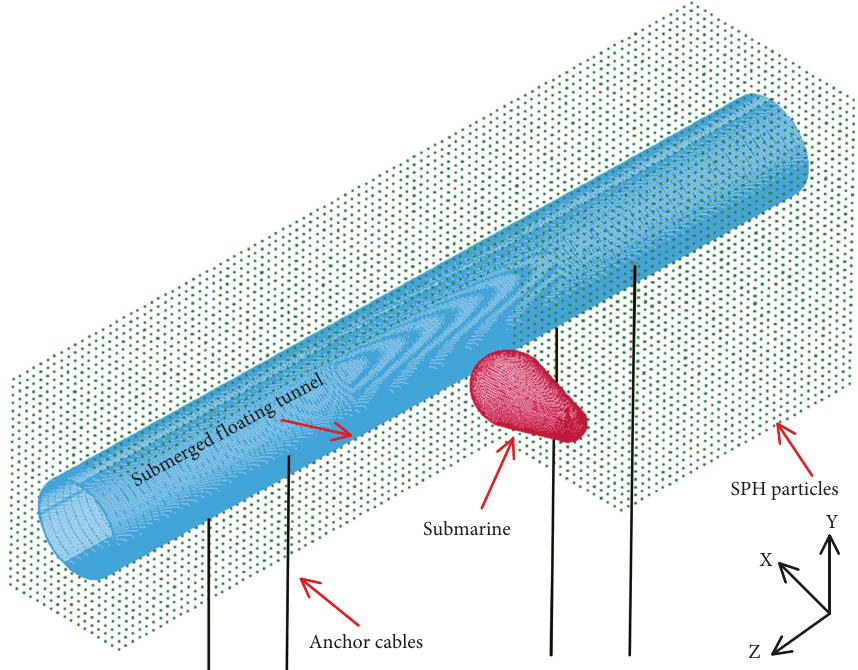
Figure 3: Cutaway view of the model.